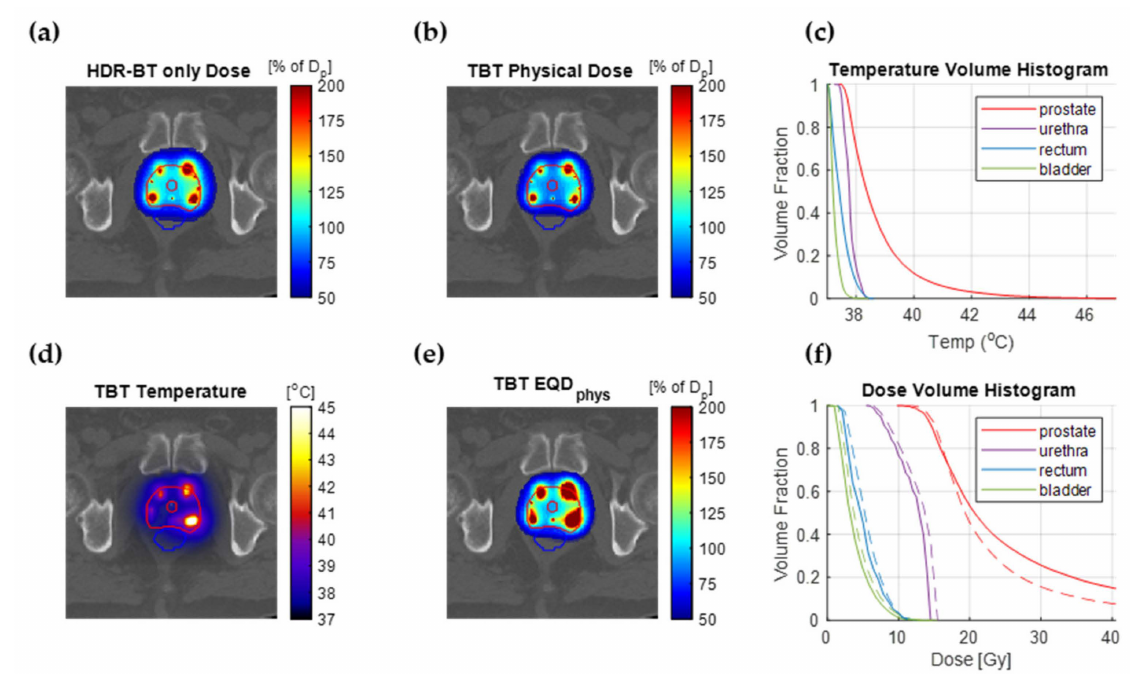
Figure 6. TBT TP results assuming thermoradiobiological parameters equal to the average between DU-145 and PC-3 data. ( a ) The original clinically applied HDR-BT dose fraction. ( b ) The applied TBT physical dose (80% of original). ( c ) Temperature volume histogram showing the temperature coverage in the prostate and OARs. ( d ) The temperature distribution calculated for the optimal TBT plan. ( e ) The TBT EQD phys resulting from the combined treatment. ( f ) Dose volume histogram of the prostate and OARs for the HDR-BT-only dose (dashed line) and the TBT EQD phys dose (solid